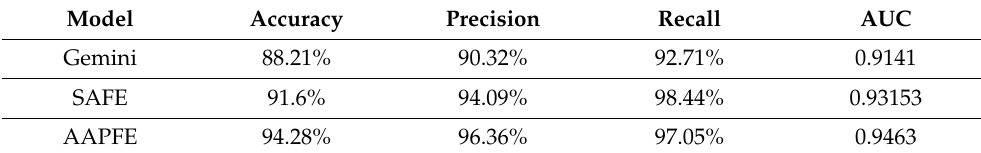
Table 6. Comparison of different models applied in malware detection.